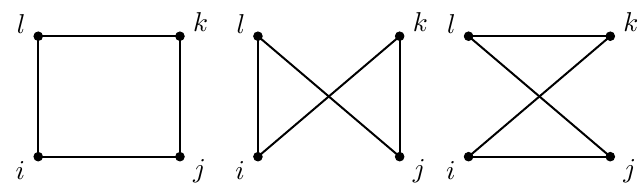
Figure 6 . Graph representation of one class of contributions of the correlator of four twist operators to I 4 when the twist operators have non-trivial support on four sheets.